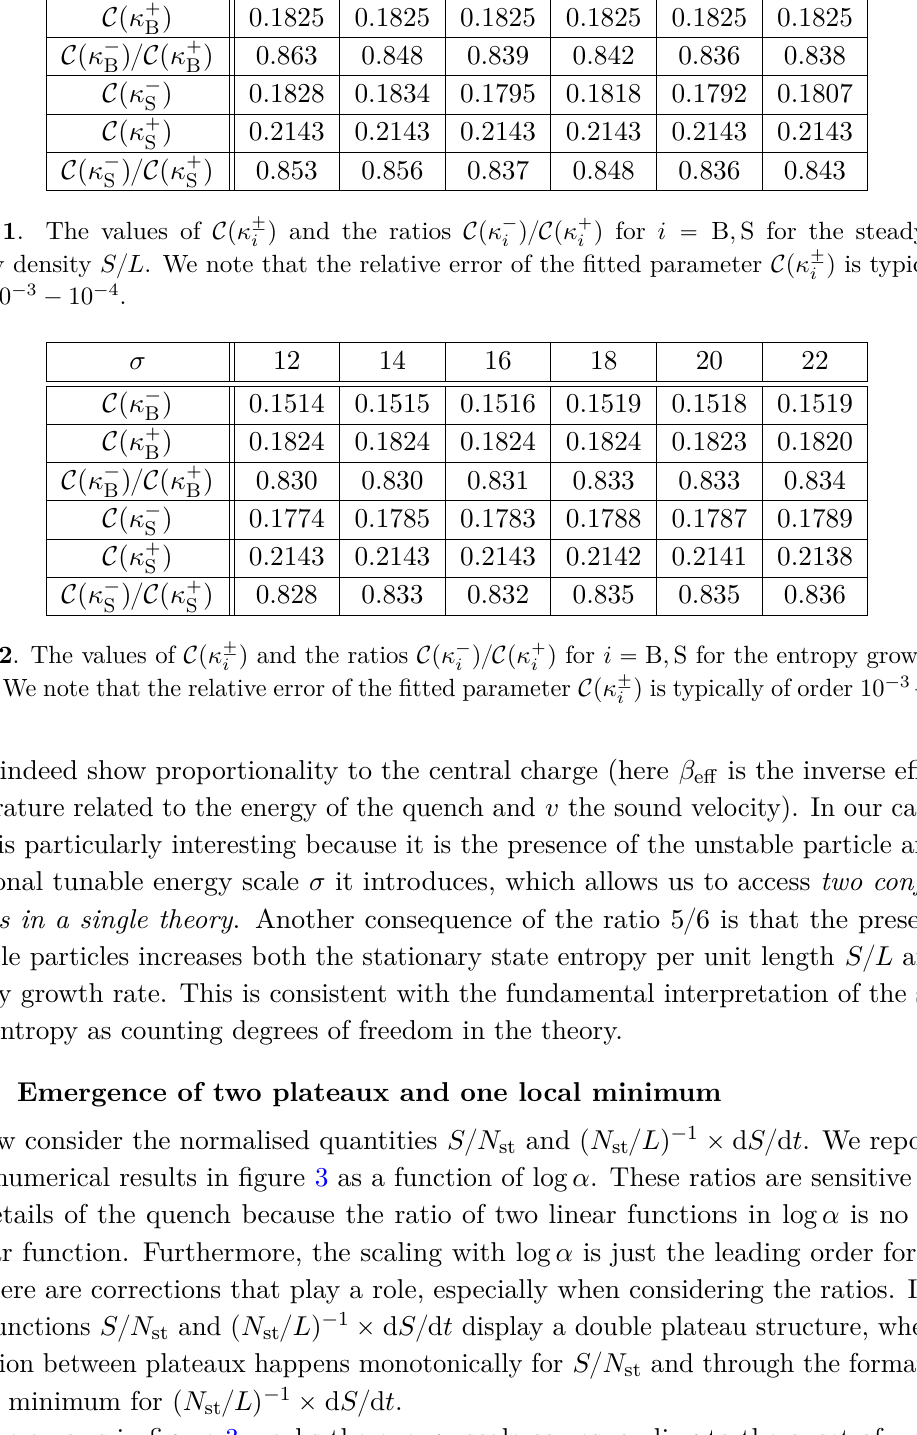
q{ C p κ ` q for i “ B , S for the steady state i i